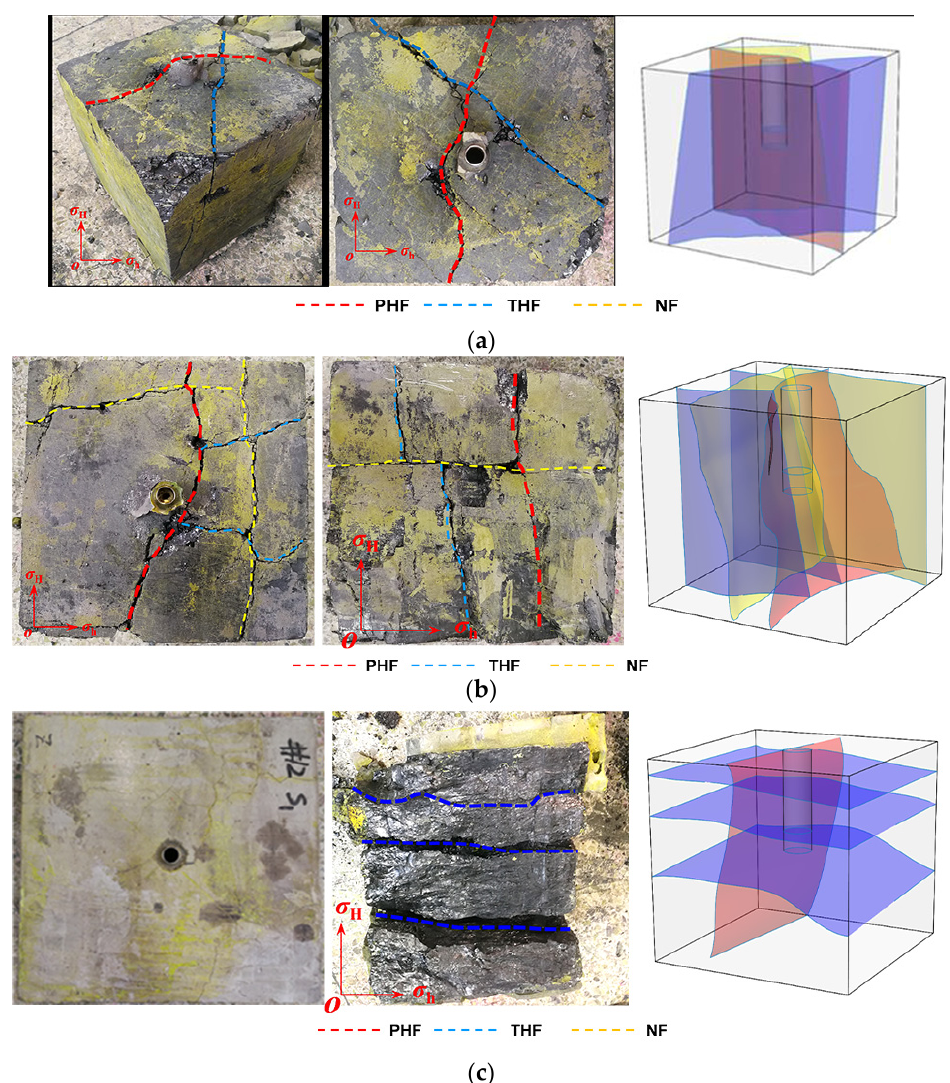
Figure 5. Fracture morphology of samples 1#-3# after TPDF: ( a ) fracture morphology of sample 1#; ( b ) fracture morphology of sample 2#; ( c ) fracture morphology of sample 3#.